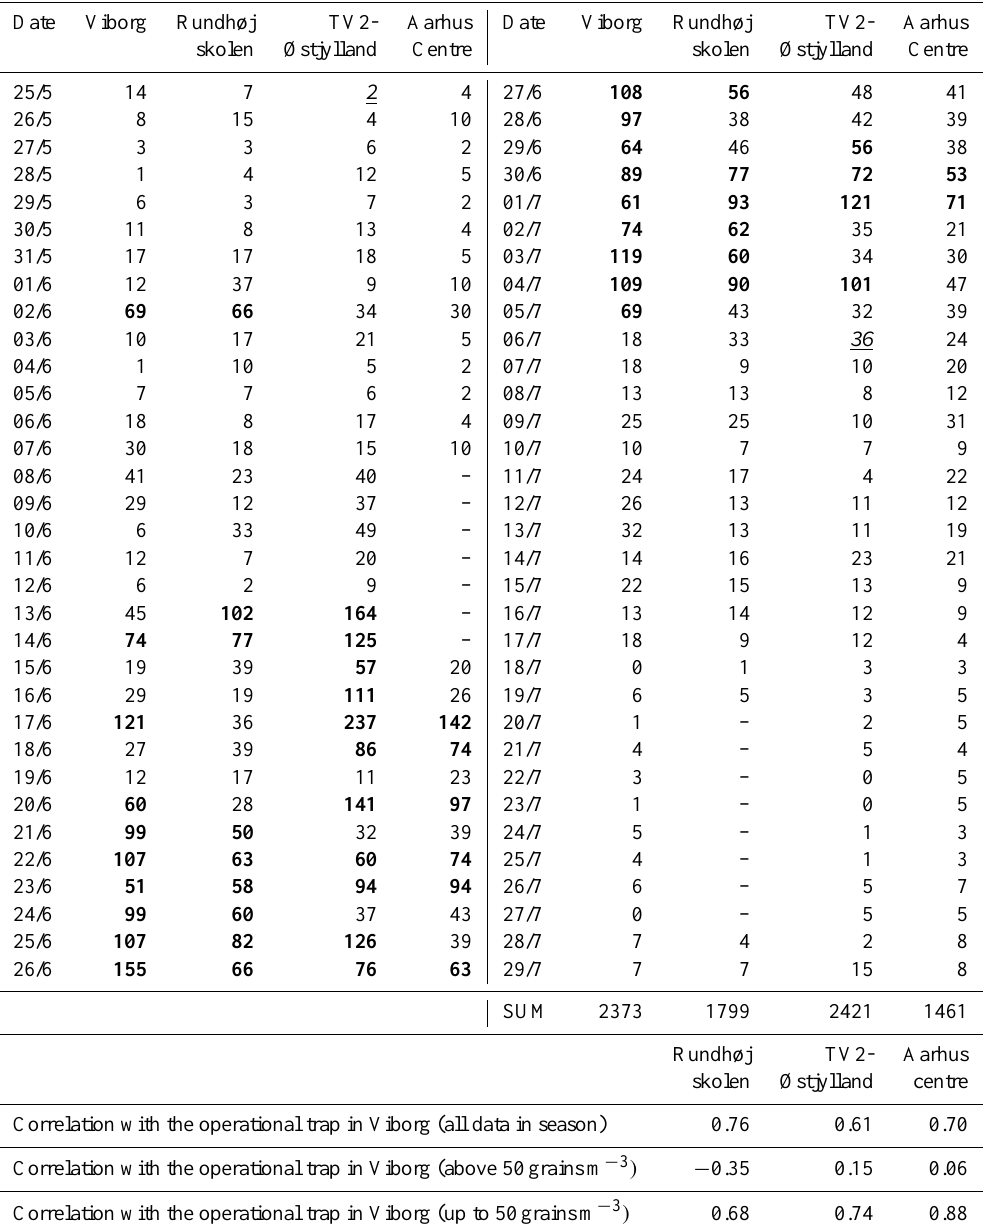
Table 1. Daily pollen counts in the city of Aarhus and corresponding daily data from the operational monitoring trap in Viborg located ∼ 60km away. Numbers in bold exceed the critical threshold for severe hay fever symptoms. Underlined, italicised numbers and “–” mark either a reduced or a missing daily measurement, respectively, due to trap